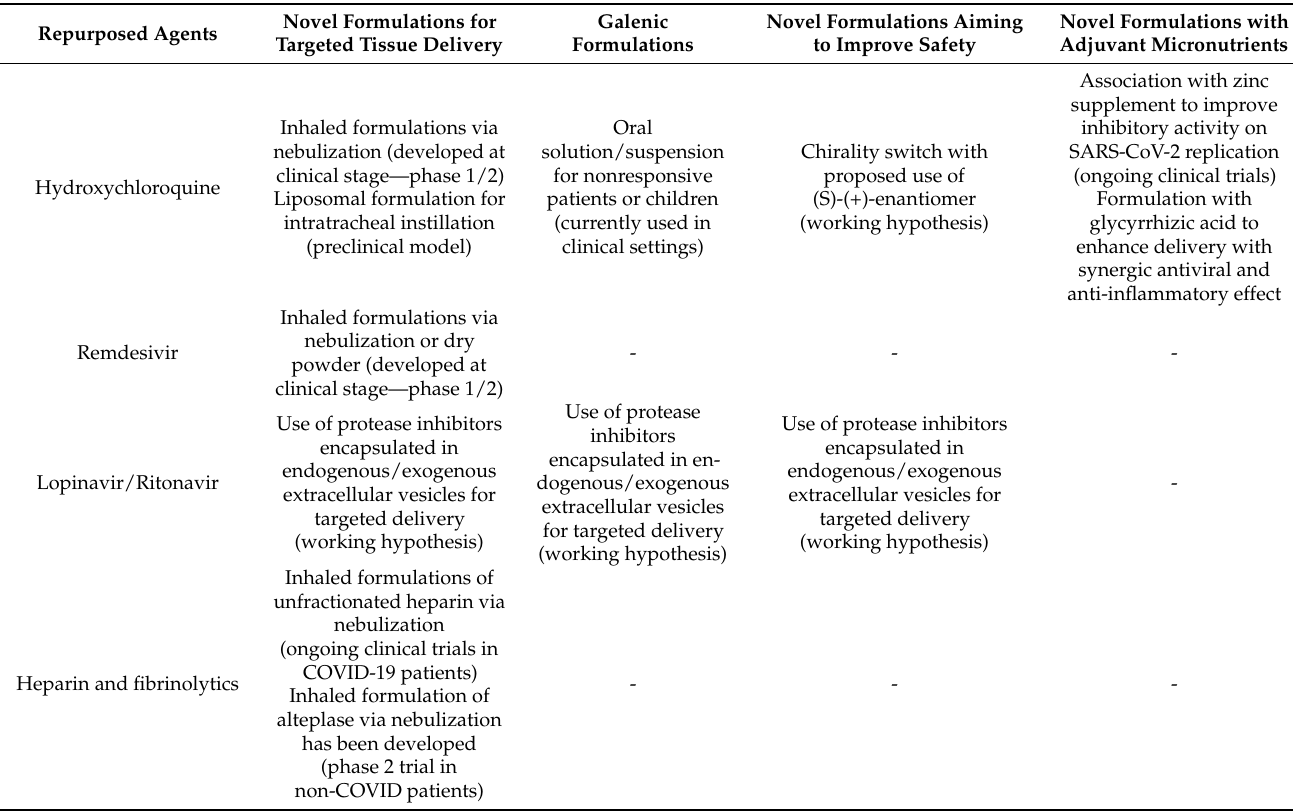
Table 3. Summary of novel relevant pharmaceutical formulations for repurposed drugs implemented for COVID-19. Repurposed